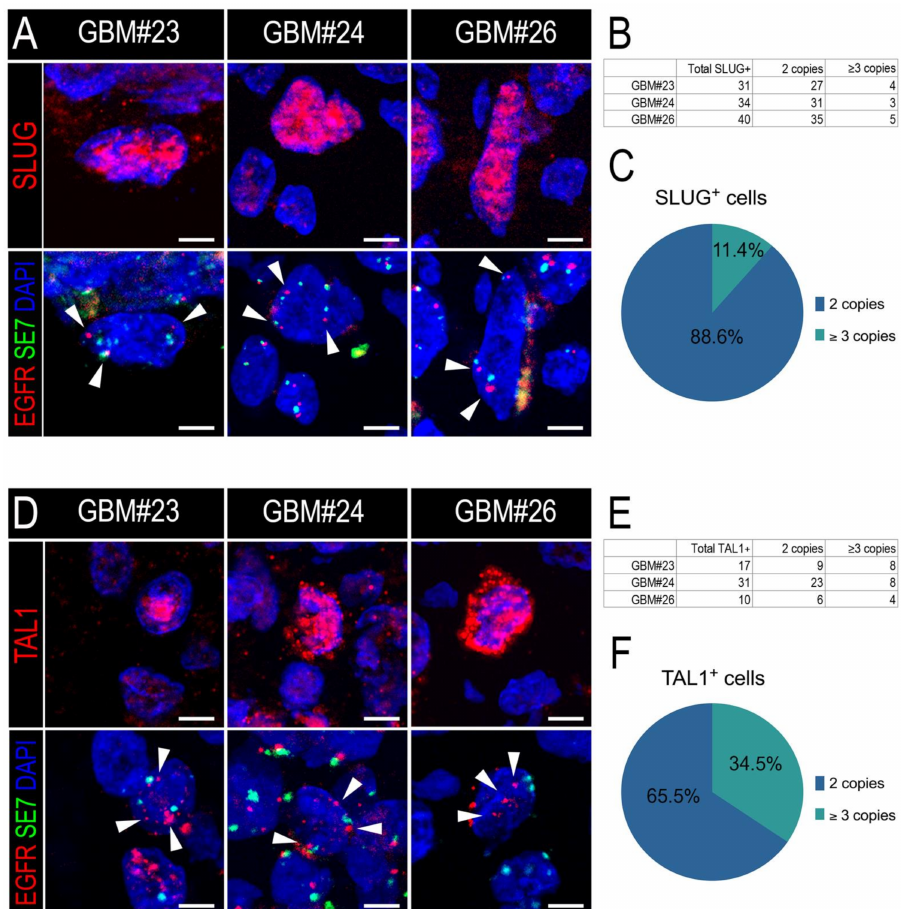
Figure 5. SLUG + and TAL1 + cells respectively contain a minor proportion of EGFR -amplified cells in GBM resections. ( A , D ) Representative images of SLUG + ( A ) and TAL1 + ( D ) cells amplified for EGFR in GBM#23, #24, and #26 using our sequential IF-FISH method. Left panels show IF for SLUG or TAL1 on selected cells, right panels indicate EGFR/SE7 loci on the same cells following hybridization with the dual EGFR/SE7 FISH probe. Amplification was detected by the number of EGFR copies (red dots) compared to the number of SE7 copies (green dots) per nucleus, here serving as a centromeric control for chromosome 7. White arrowheads indicate EGFR loci in nuclei. Owing to the applied sequential method and post-treatment for FISH hybridization, nuclei appear slightly different in the right panels; scales 5 µ m. DAPI: 4 (cid:48) ,6-diamidino-2-phenylindole; EGFR: EGFR locus-specific probe; SE7: satellite enumeration probe for chromosome 7. ( B , E ) Quantification tables of EGFR amplification in SLUG + ( B ) or TAL1 + ( E ) cells in each GBM sample. Cells with 3 EGFR copies or more were quantified as amplified, cells with 2 EGFR copies and 2 SE7 copies were quantified as non-amplified. ( C , F ) Pie graphs showing the average percentage of SLUG + ( C ) or TAL1 + ( F ) EGFR -amplified versus non-amplified cells across all GBM